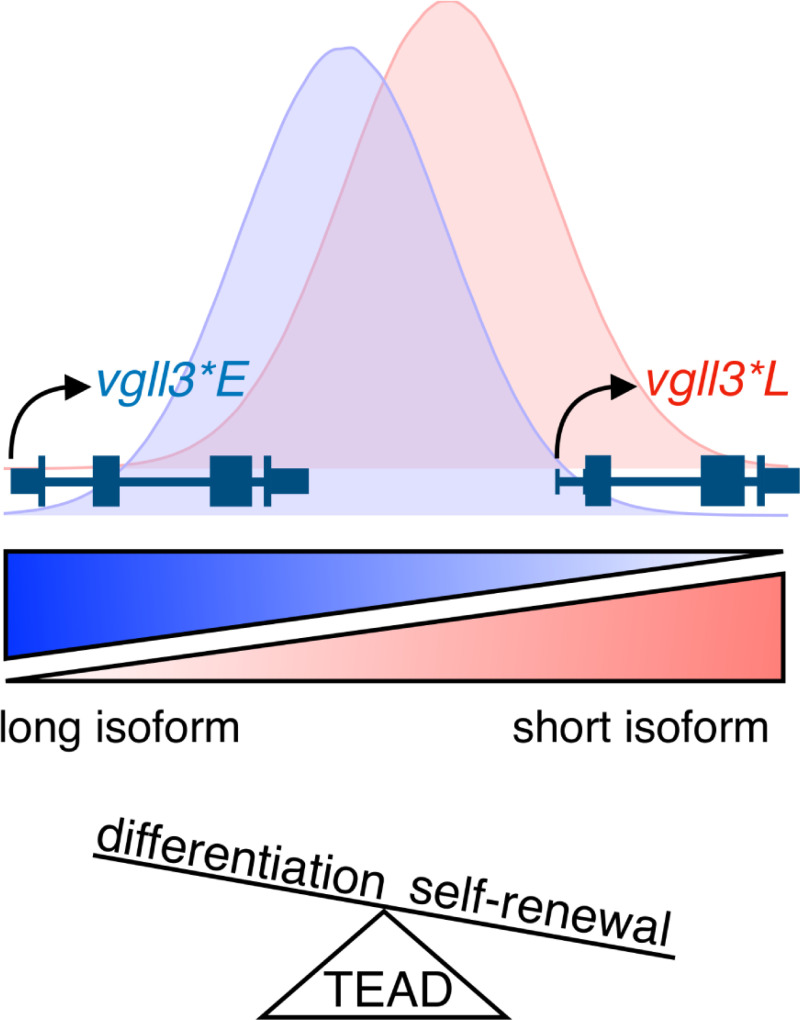
Model for a molecular mechanism of vgll3 genotype-dependent liability in puberty timing.Hypothetical distributions represent relative abundances of vgll3 isoforms in individuals with given vgll3 genotypes (blue, vgll3*E; red, vgll3*L). We hypothesize that cis-regulatory differences influencing vgll3 isoform expression are an important mechanism contributing to the association between vgll3 genotype and maturation timing. The vgll3*L allele tends to express more of the shorter isoform compared to the vgll3*E allele, thus potentially changing the balance between vgll3-controlled differentiation versus self-renewal. TEAD interaction with vgll3 isoforms may tip the balance between tendency for self-renewal (higher expression of the short isoform) and differentiation (long isoform).